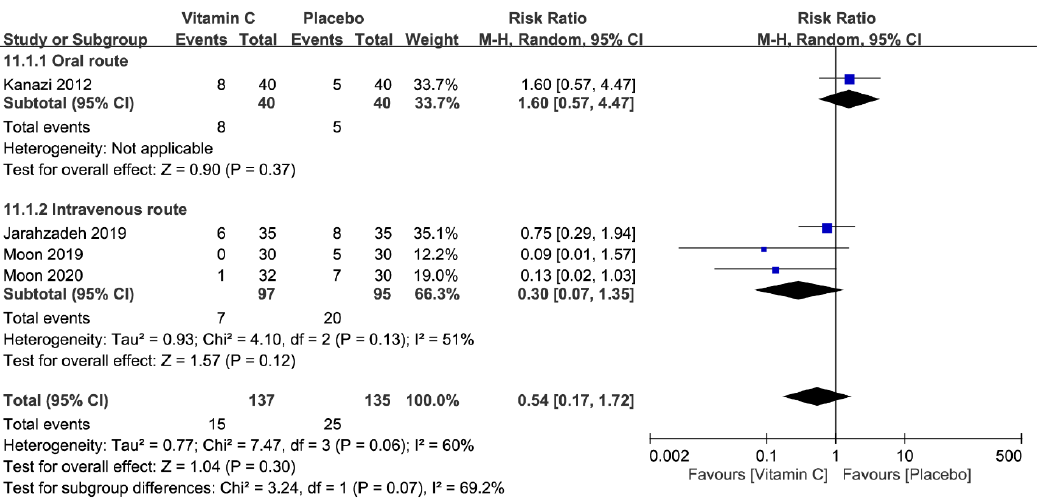
Figure 12. Forest plot for comparing the incidences of postoperative nausea or vomiting within postoperative 1–2 h between vitamin and placebo groups. CI, confidence interval; RR, risk ratio; M-H = Mantel–Haenszel.